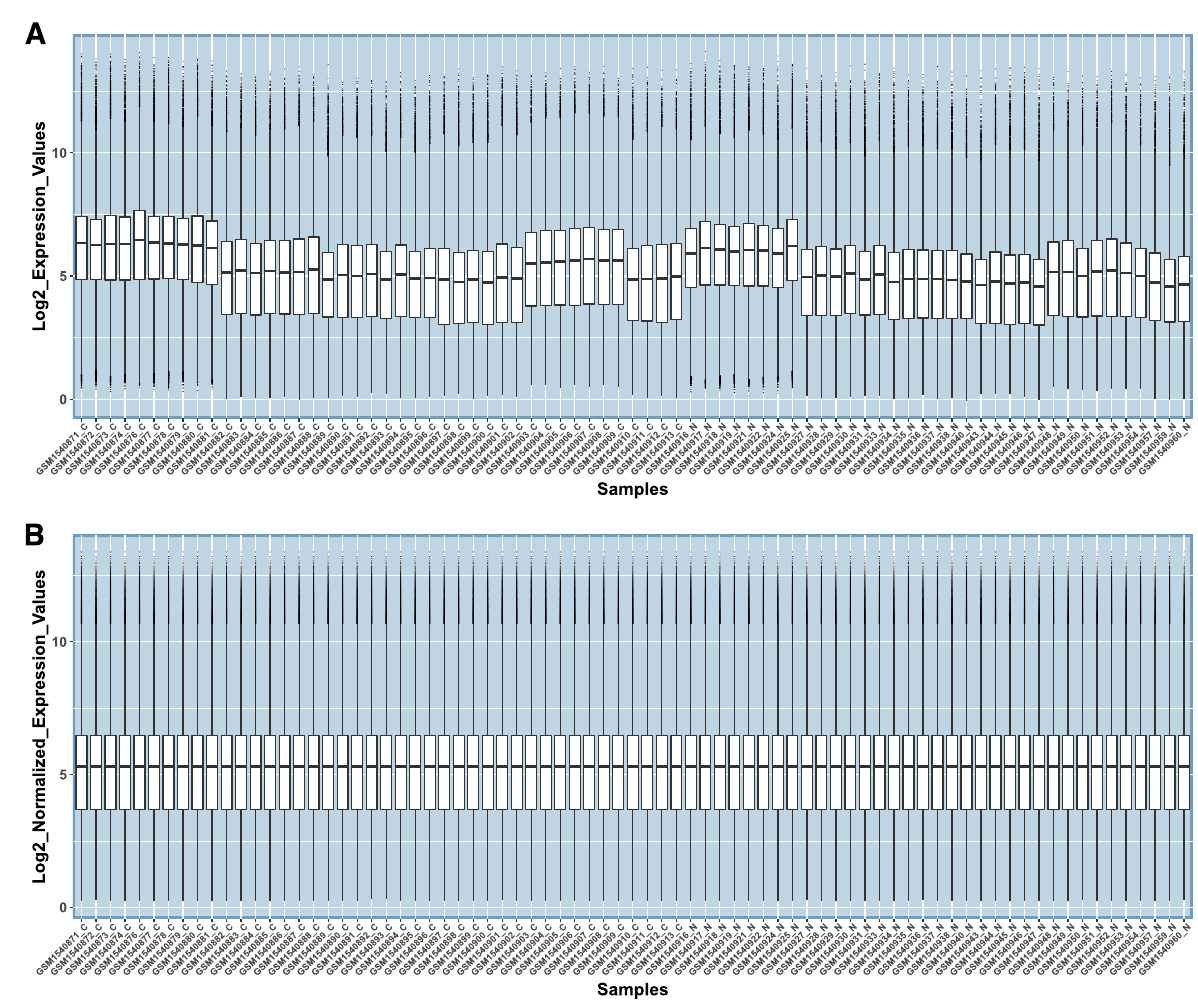
Fig. 2 Boxplots before ( A ) and after normalization ( B ). Sample names with the suffix N are normal, and the ones with the suffix C are cancerous. Values were log2 transformed. Quantile normalization equalized the percentiles of all